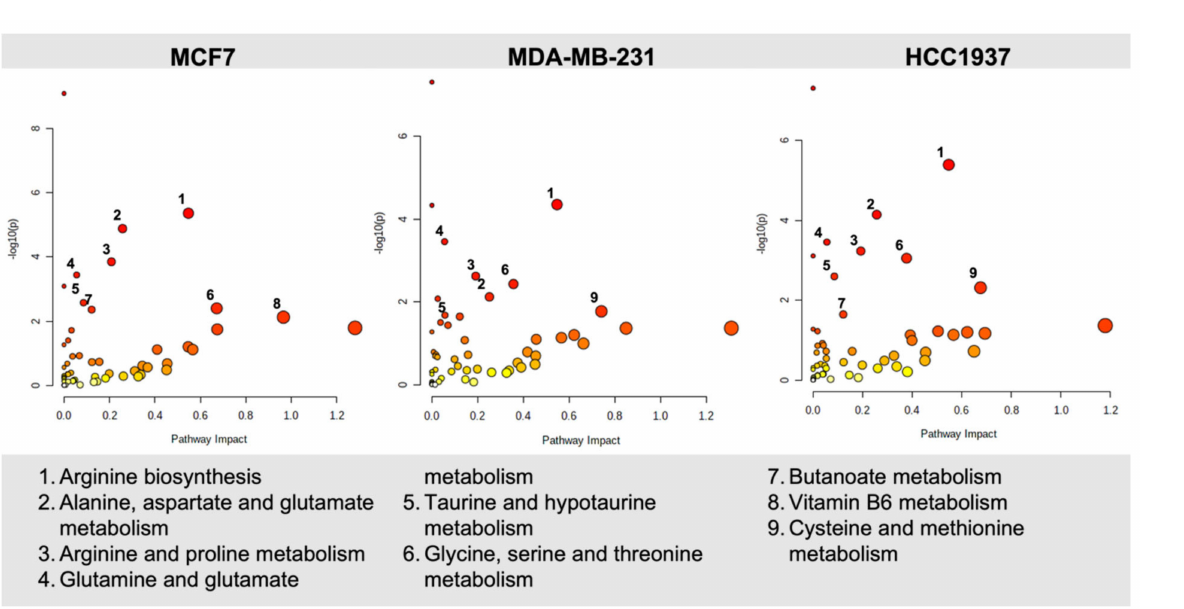
Figure 5. Pathway enrichment analysis of MCF7 (10 µ M), MDA-MB-231 (14 µ M), and HCC1937 (150 µ M) cells following a seven-day exposure to olaparib. Enrichment analysis was based on the hypergeometric test. Topological analysis was based on betweenness centrality. The tight integration method was used by combining genes and metabolites into a single query. A p < 0.05, and pathway impact >0.1 were deemed